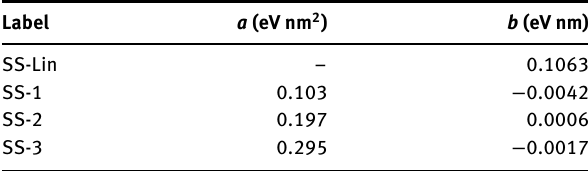
Table 1: Parametrization of linearly and parabolically dispersing resonances associated with Shockley surface states in the nonlinear optical response. We provide fitting parameters according to the expression ℏ𝜔 = aQ 2 + bQ , also plotted in Figure 4. The SS-Lin line is taken from ref